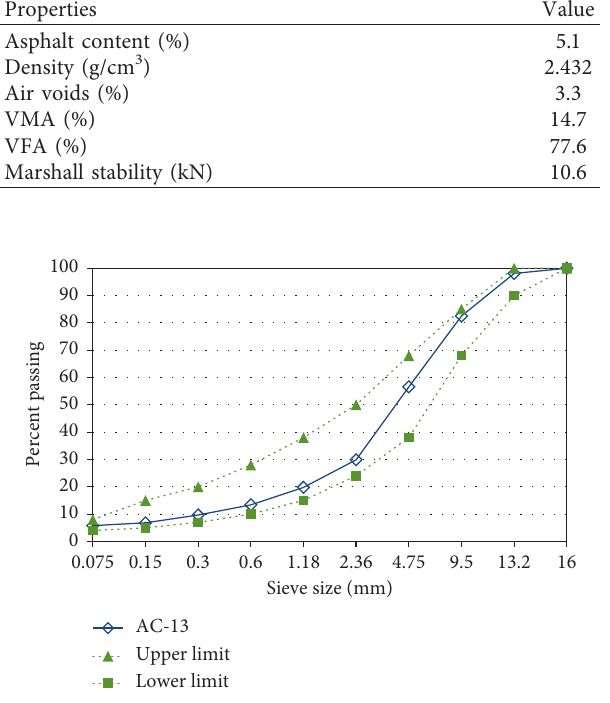
Figure 2: The aggregate gradation of the AC-13